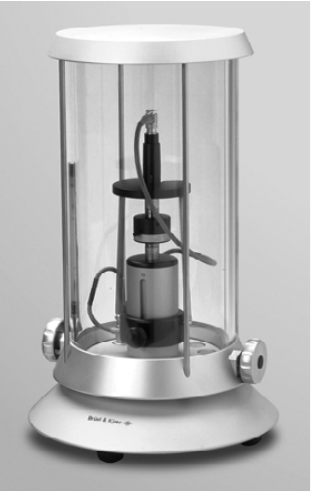
Fig. 6. Measurement chamber designed for reduction of noise and for pressurisation.